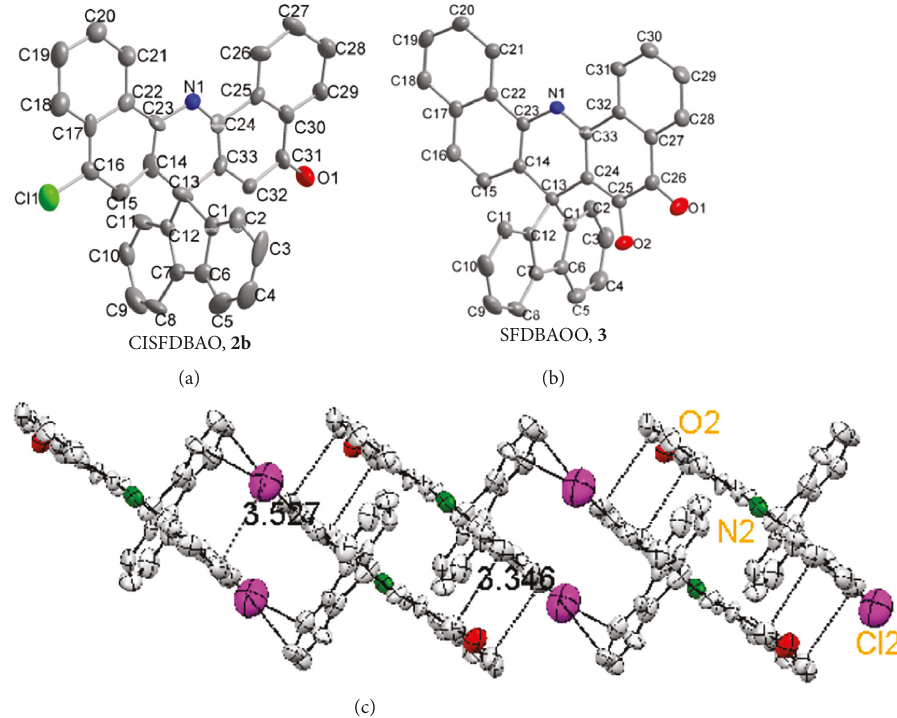
Figure 2: Single-crystal X-ray structures of 2b and 3 and the packing structure of 2b .